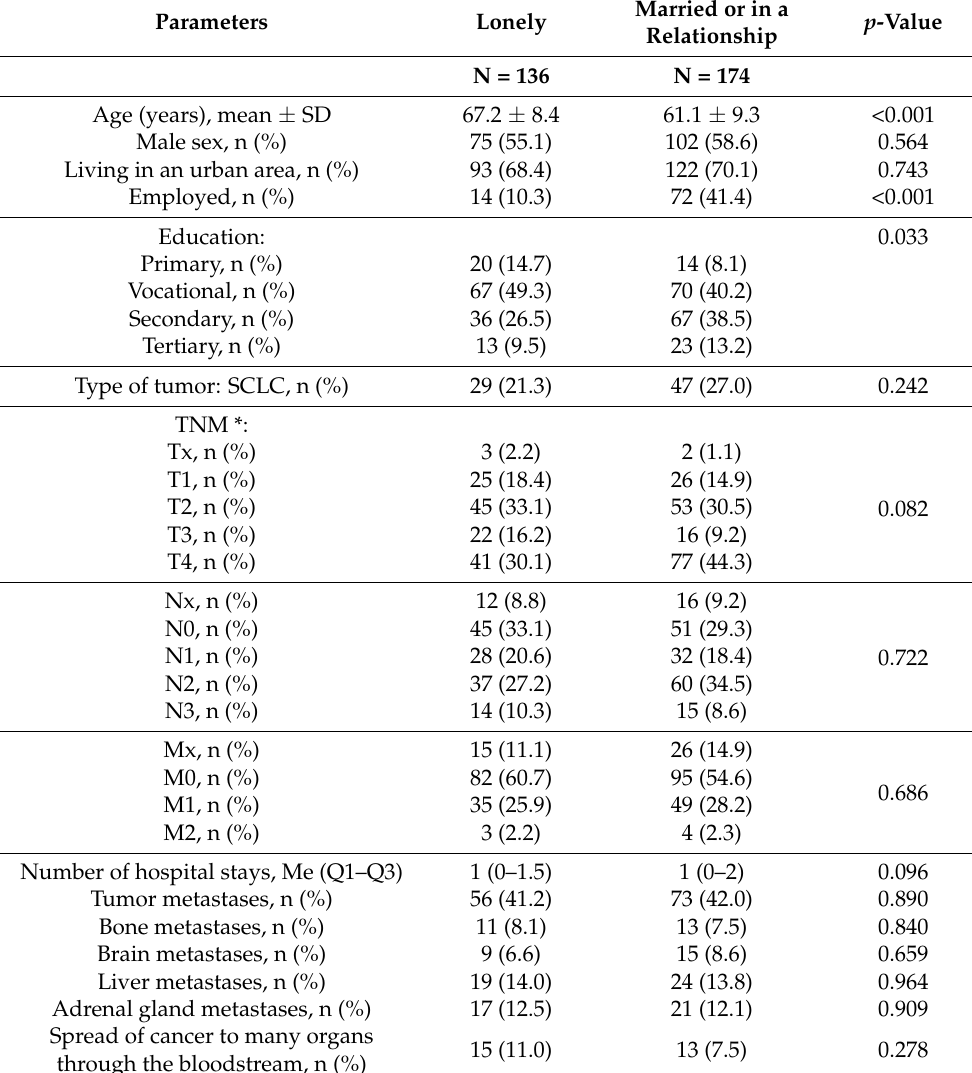
Table 1. General characteristics of 310 patients divided into two groups based on their marital status. Parameters Lonely